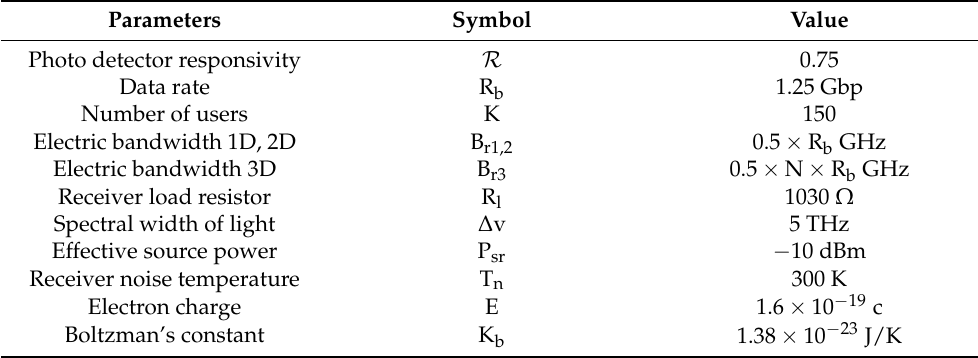
Table 5. The values of the parameters in the 3D-VWZCC system for numerical calculation. Parameters Symbol Value Photo detector